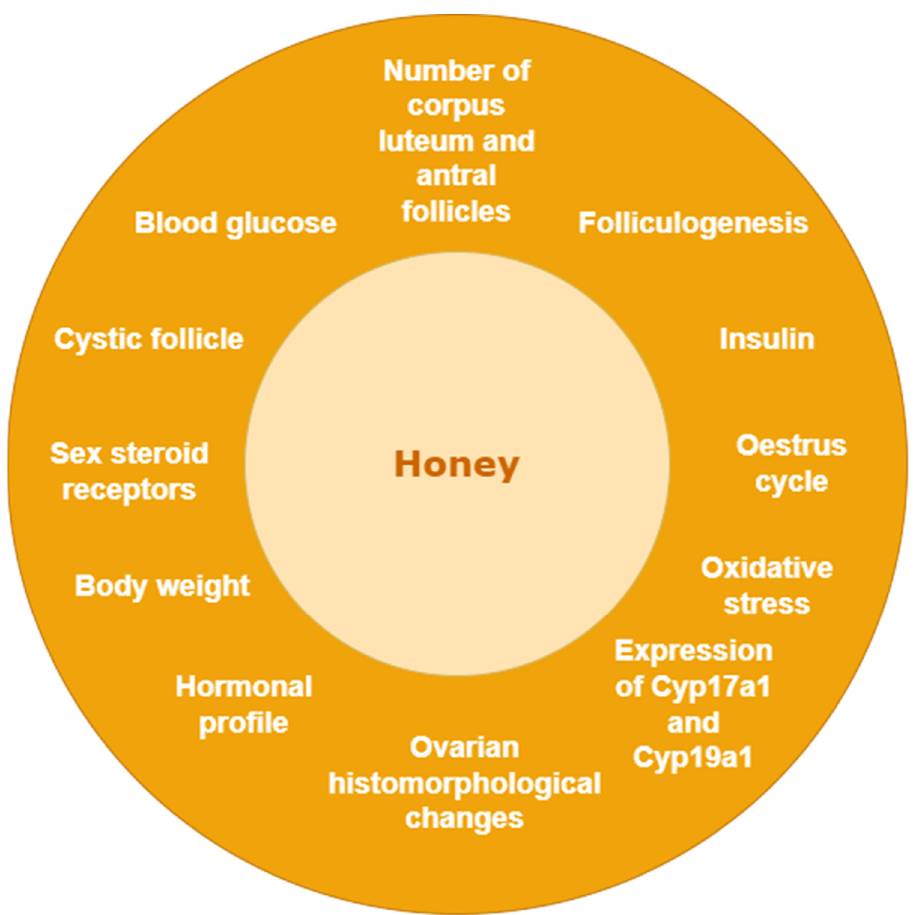
Figure 3. Honey-affected parameters related to PCOS.